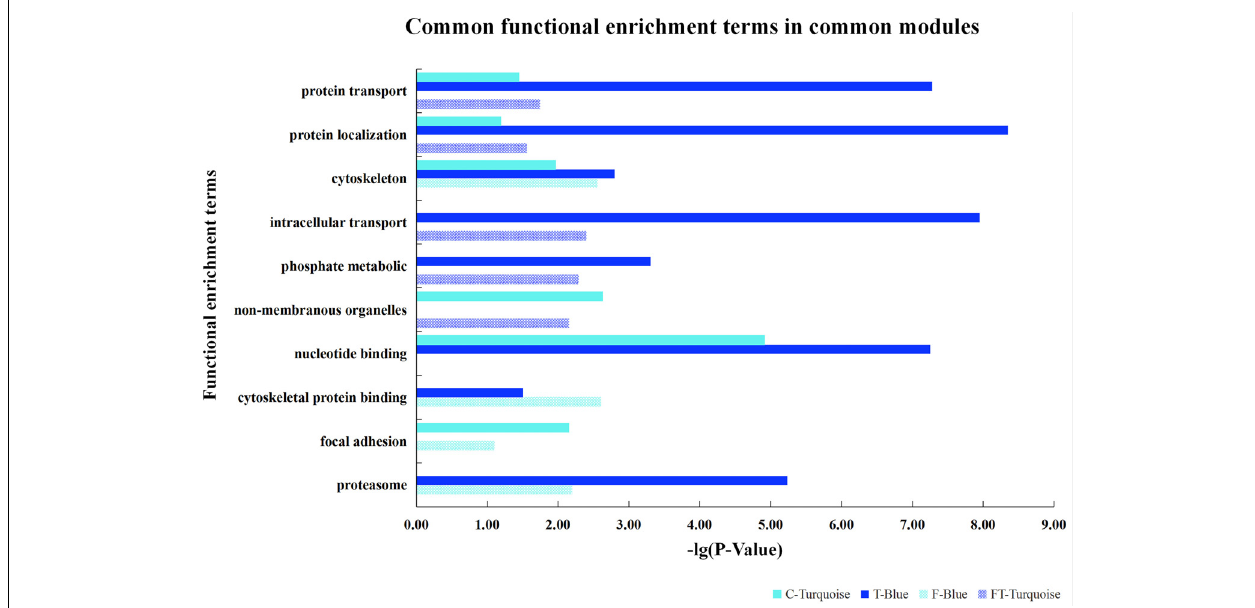
FIGURE 4 | Common gene modules discovered for different chicken lines.